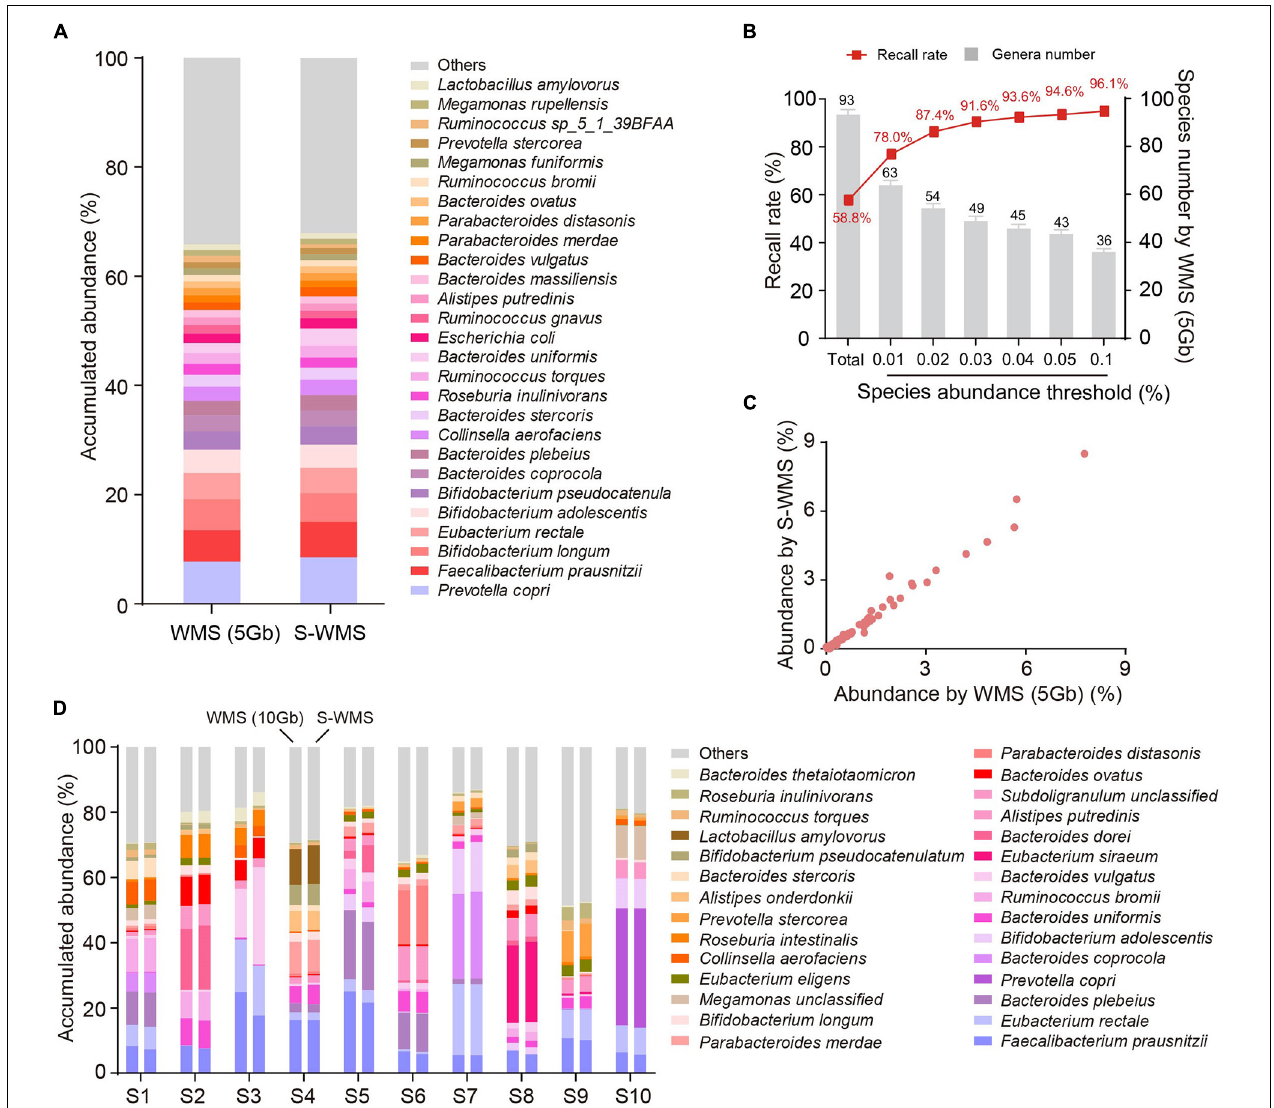
FIGURE 4 | The species assignment provided by S-WMS and classical WMS. (A) Stacked bar plot of species abundances determined by classical (5 Gb depth) or S-WMS sequencing. (B) The recall rate of species types. The values on top of gray bars indicate the species numbers above each relative abundance threshold. The percentages on top of the curve nodes indicate the recall rate at each species abundance threshold. (C) Scatterplot of relative abundances of species determined by S-WMS versus classical WMS (5 Gb depth). (D) Stacked bar plot of species abundances in 10 typical fecal samples determined by WMS (10 Gb depth) or shallow (1 Gb depth) shotgun sequencing. The metagenomes of 59 human stool samples were